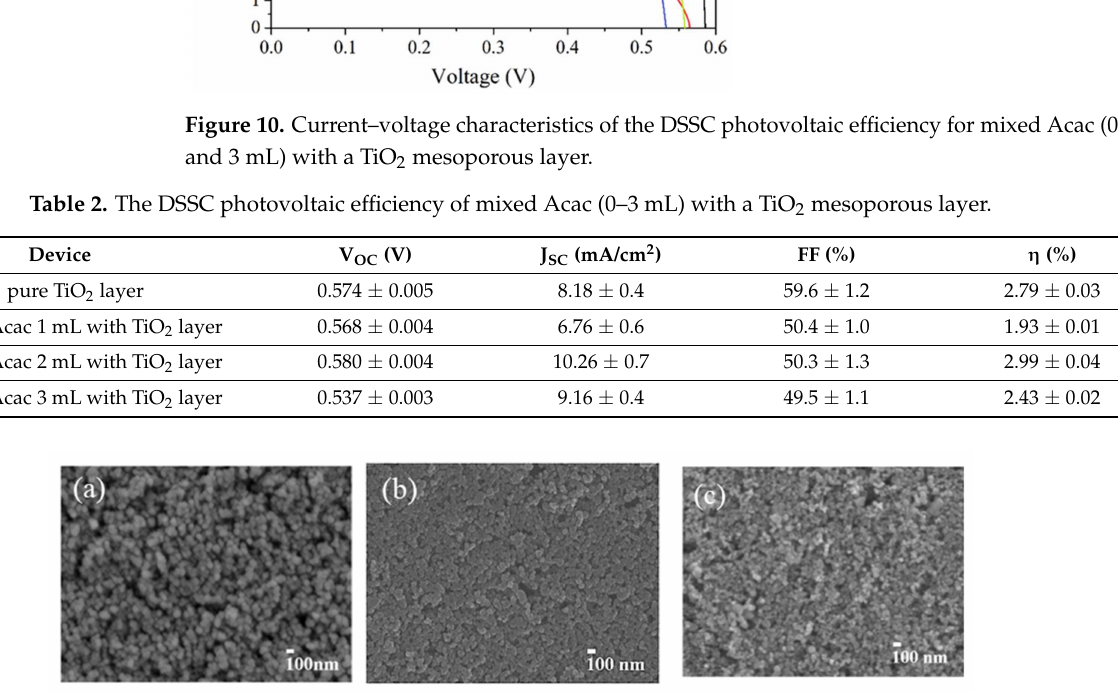
Figure 11. SEM photographs of the mixed Acac and GP with a TiO 2 mesoporous layer: ( a ) Acac 2 mL + GP 0.001 wt.%, ( b ) Acac 2 mL + GP 0.003 wt.% and ( c ) Acac 2 mL + GP 0.005